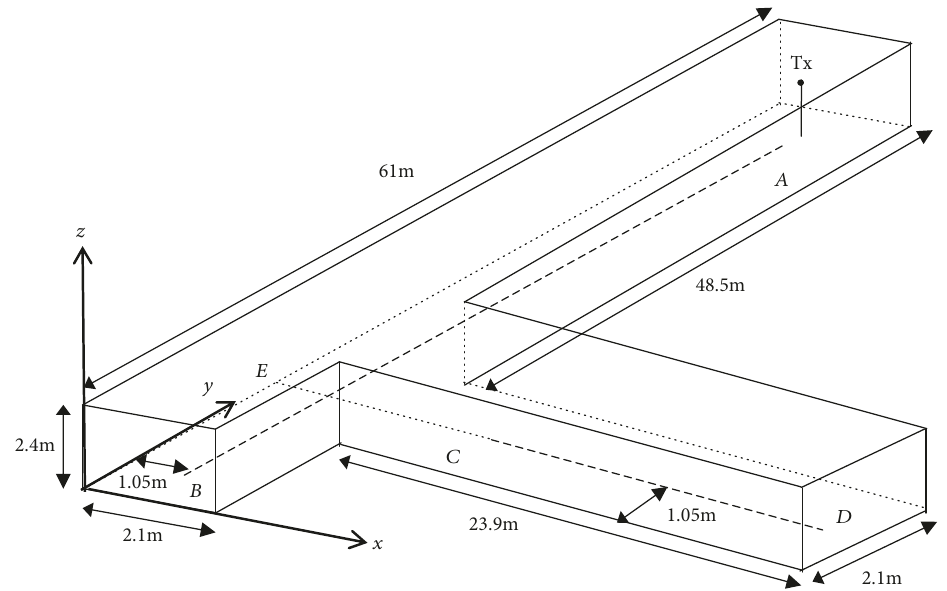
Figure 1: The three-dimensional layout of the T-shaped